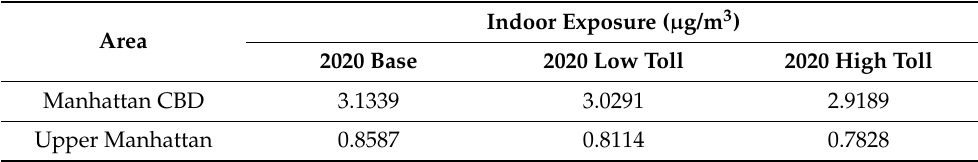
Table 3. Employee indoor exposure to PM2.5 emissions for pricing scenarios (single employee